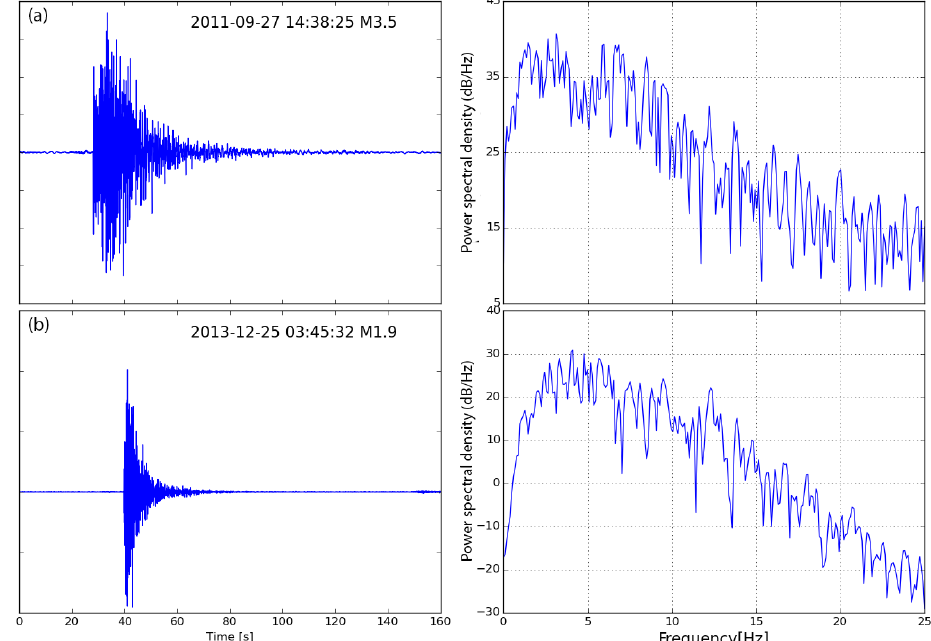
Figure 1. Characteristic VT earthquakes of the El Hierro seismo-volcanic process and their spectra. (a) Event recorded on 27 September 2011, before the eruption, at 6.3km to the SE of the island centre. (b) Event recorded on 24 December 2013, after the eruption at ∼ of the island